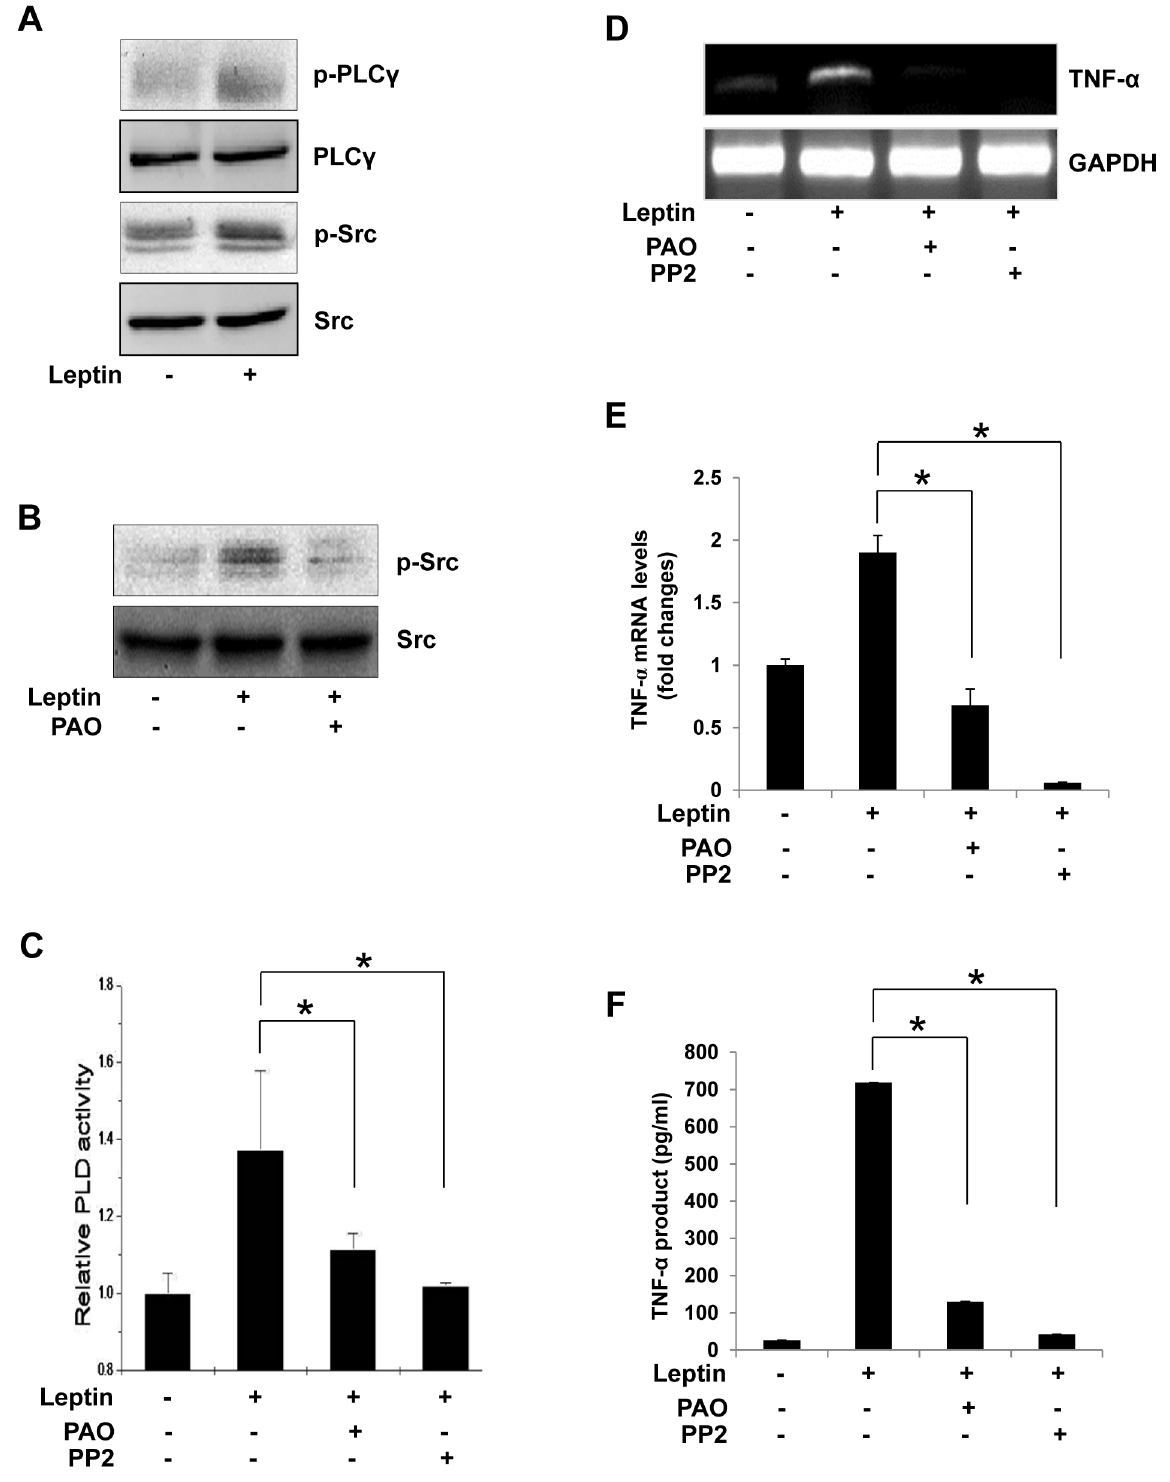
Figure 3. Effect of the PLC c inhibitor (PAO) and Src kinase inhibitor (PP2) on leptin-induced TNF- a expression in Raw 264.7 cells. (A) Raw 264.7 cells were treated with leptin (20 nM) for 5 min. Cells were harvested, and cell extracts were subjected to immunoblotting for PLC c and Src kinase, respectively. (B) Cells were pretreated with PAO (20 m M) for 30 min and then stimulated with leptin (20 nM) for 5 min. The cell lysates were then analyzed by Western blotting using total Src and p-Src antibodies. (C) Cells were labeled with 2 m Ci/ml [ 3 H]-palmitic acid and then pretreated with PAO or PP2 (20 m M) for 30 min before stimulation with leptin (20 nM) for 15 min. PLD activity was determined by estimating the formation of [ 3 H]-PBt in the presence of 1-butanol. Results are the mean 6 S.D. of three independent experiments. *p , 0.05 vs leptin-treated control (D,E) Cells were pretreated with PAO or PP2 (20 m M) for 30 min and then stimulated with leptin (20 nM) for 30 min. Total RNA was isolated using TRIzol reagent, and mRNA levels were determined by semi-quantitative and real-time RT-PCR with primers for TNF- a or GAPDH. *p , 0.05 vs leptin-treated control. (F) Cells in 96-well culture plates were pretreated with PAO or PP2 (20 m M) for 30 min and then stimulated with leptin (20 nM) for 1 h. Results are the mean 6 S.E. amounts of TNF- a measured by ELISA for each group of samples. Data are means 6 S.E. of eight values. *p , 0.05 vs leptin-treated control. doi:10.1371/journal.pone.0102373.g003 PLOS ONE |